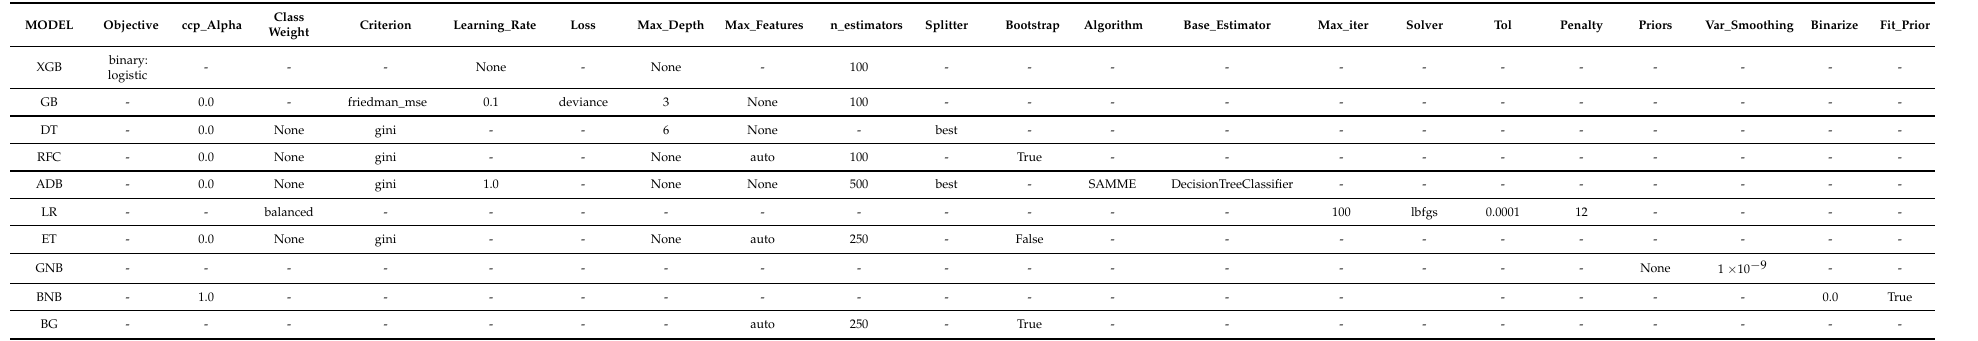
Table A3. Details about models